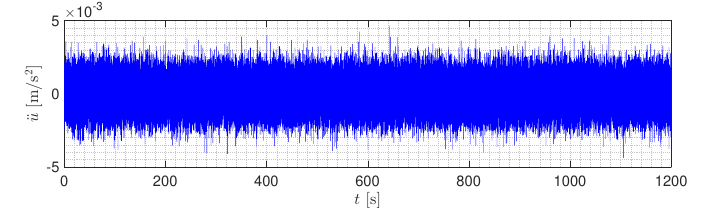
Figure 9. Input excitation signal.